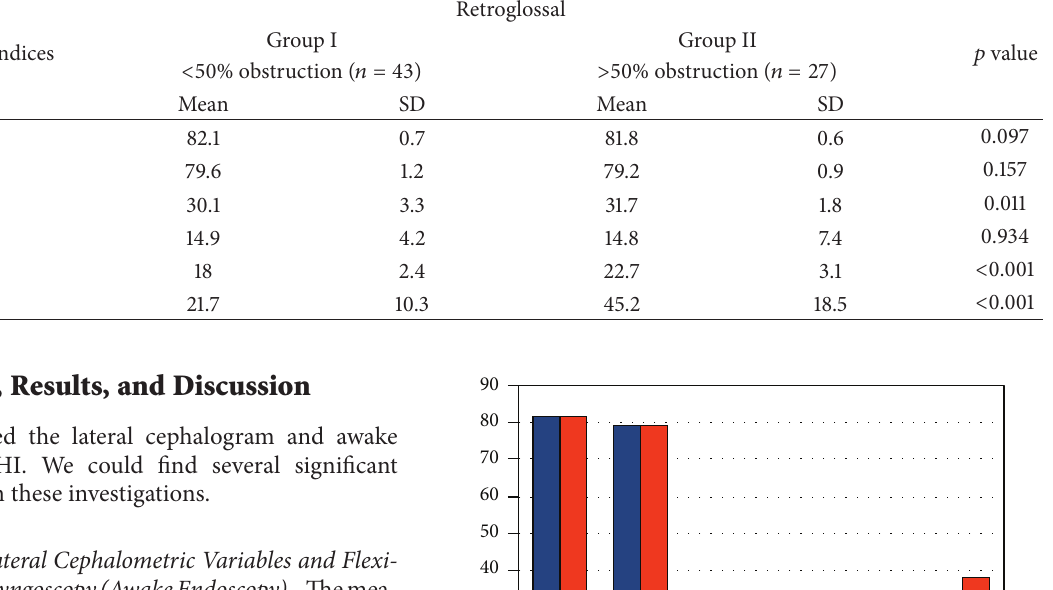
Lateral cephalogram indices